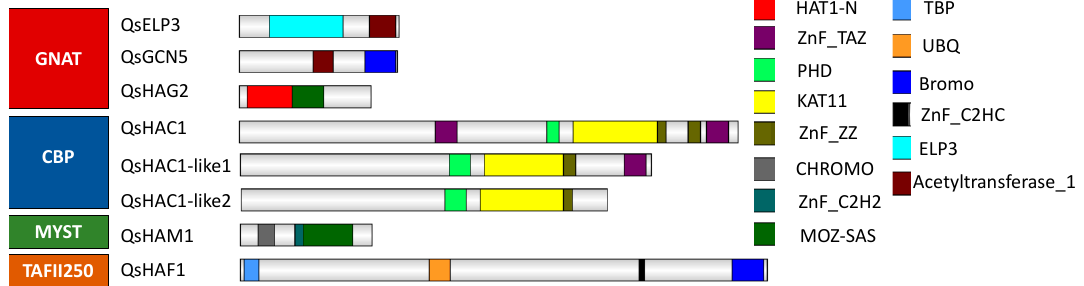
Figure 3. Domain organization of the Quercus suber L. histone acetyltransferases proteins. Schematic diagrams show the domain organization of the enzymes. The proteins and the family they belong to are indicated on the left side of each corresponding schematic diagram. The di ff erent conserved protein domains are depicted in di ff erent colors as indicated in the right side of the legend. Acetyltransferase_1 (PF00583) and C-terminal Bromo (PF00439) domains are conserved domains of QsGCN5,